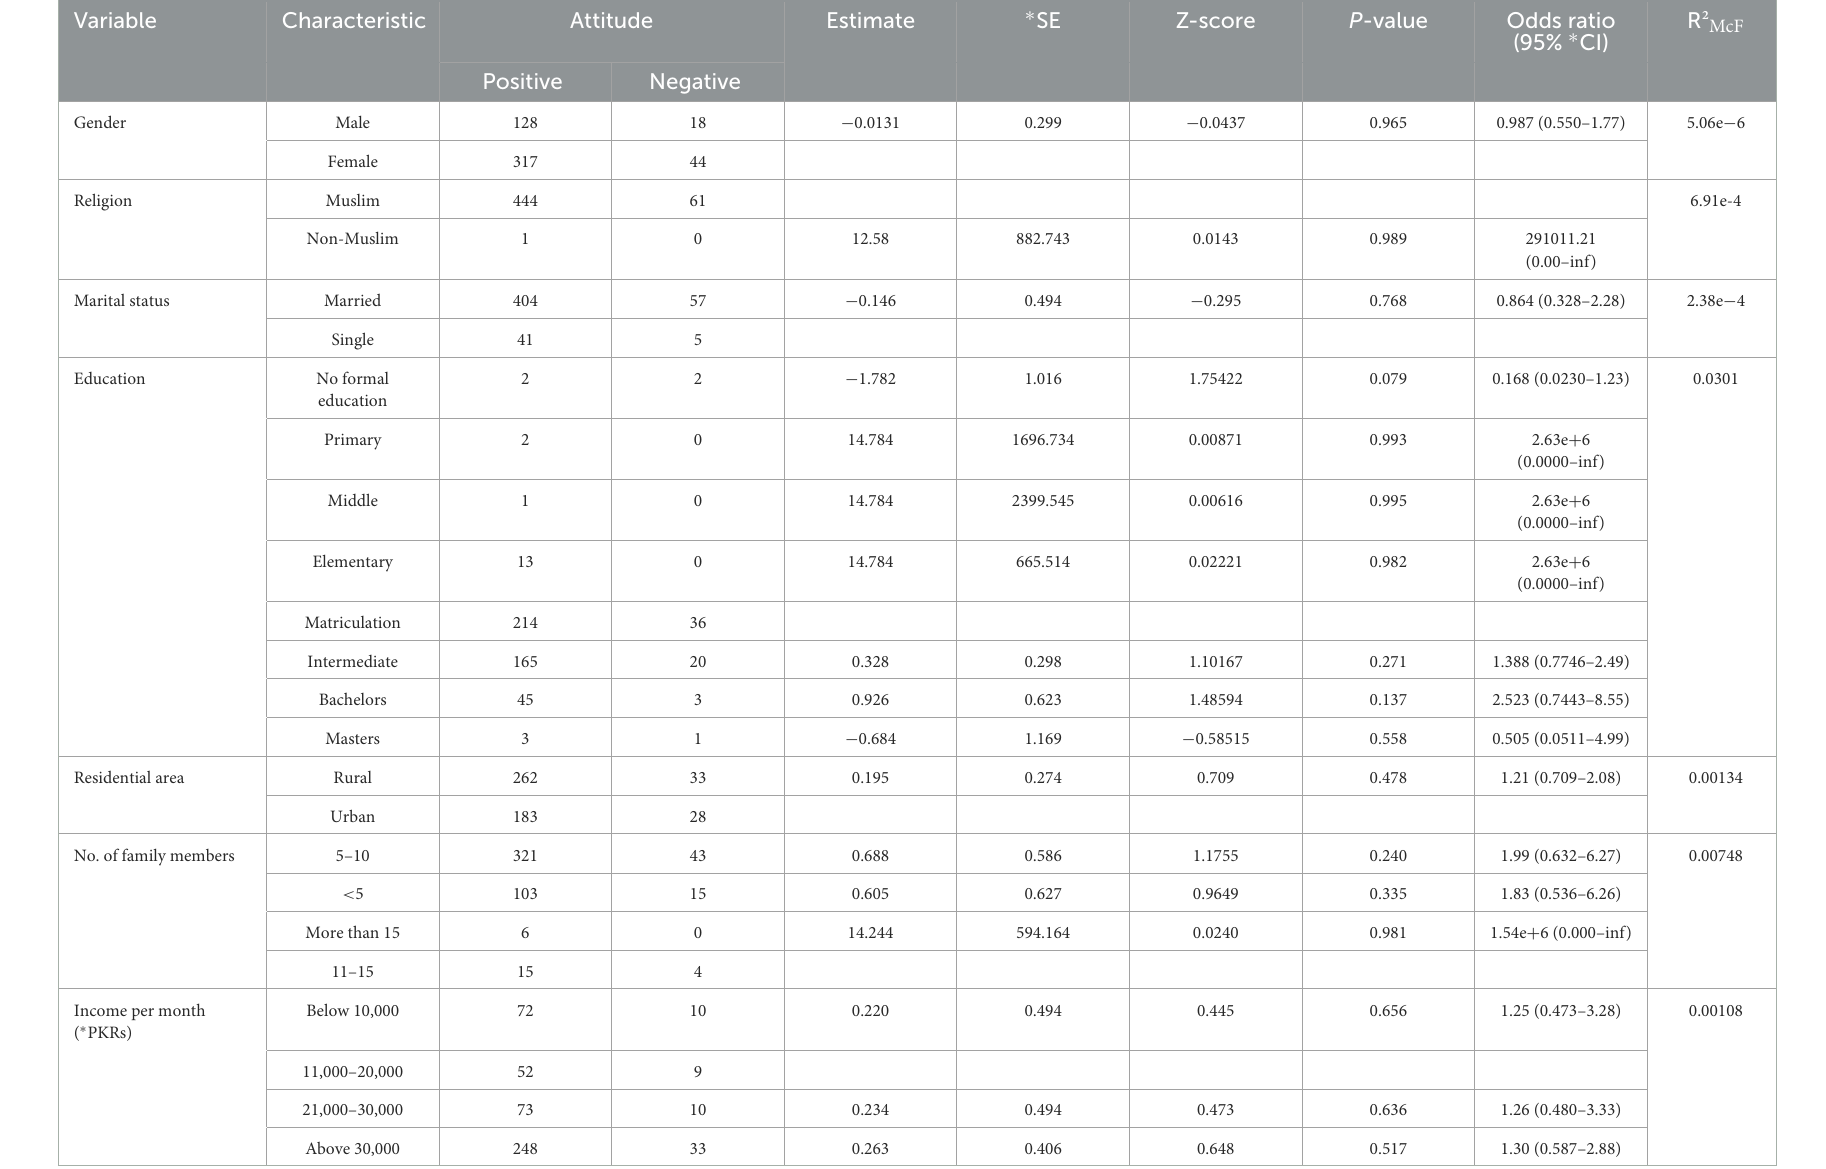
TABLE 7 Associations between participants’ attitude and socio-demographic characteristics. Variable Characteristic